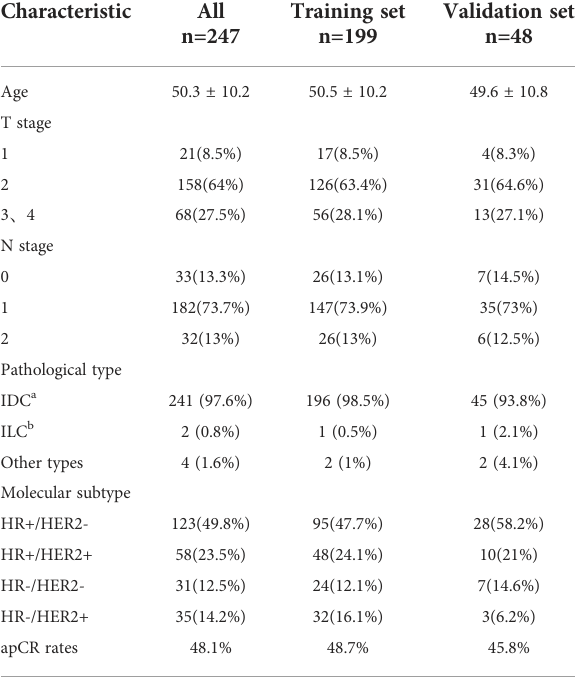
TABLE 1 Basic characteristics of patients at